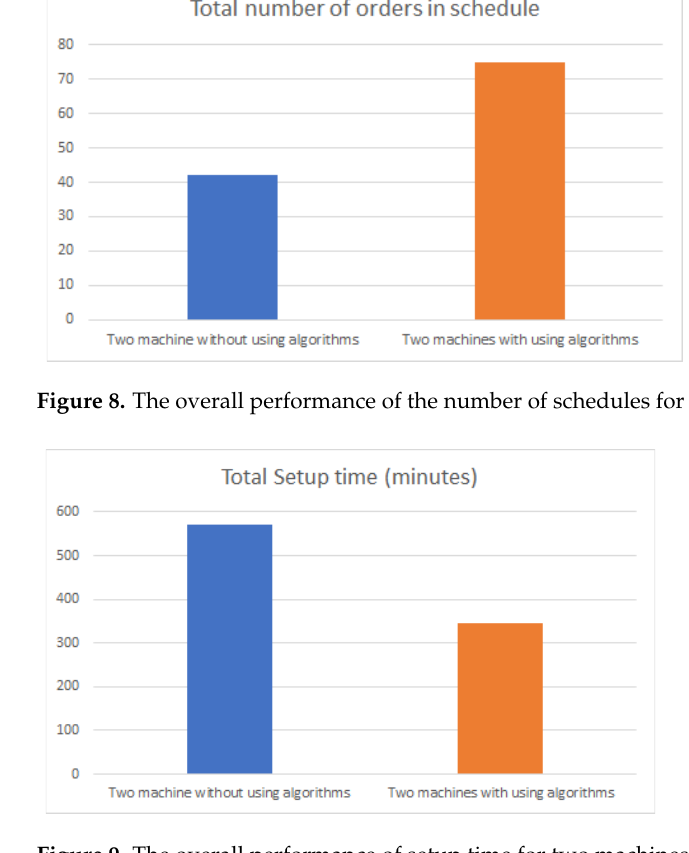
Figure 9. The overall performance of setup time for two machines. Table 6. The performance of schedule for each machine in the tw o machines’ test . Table 5. The overall performance of the total number of orders and total setup time used in the schedule. Total Number of Orders in